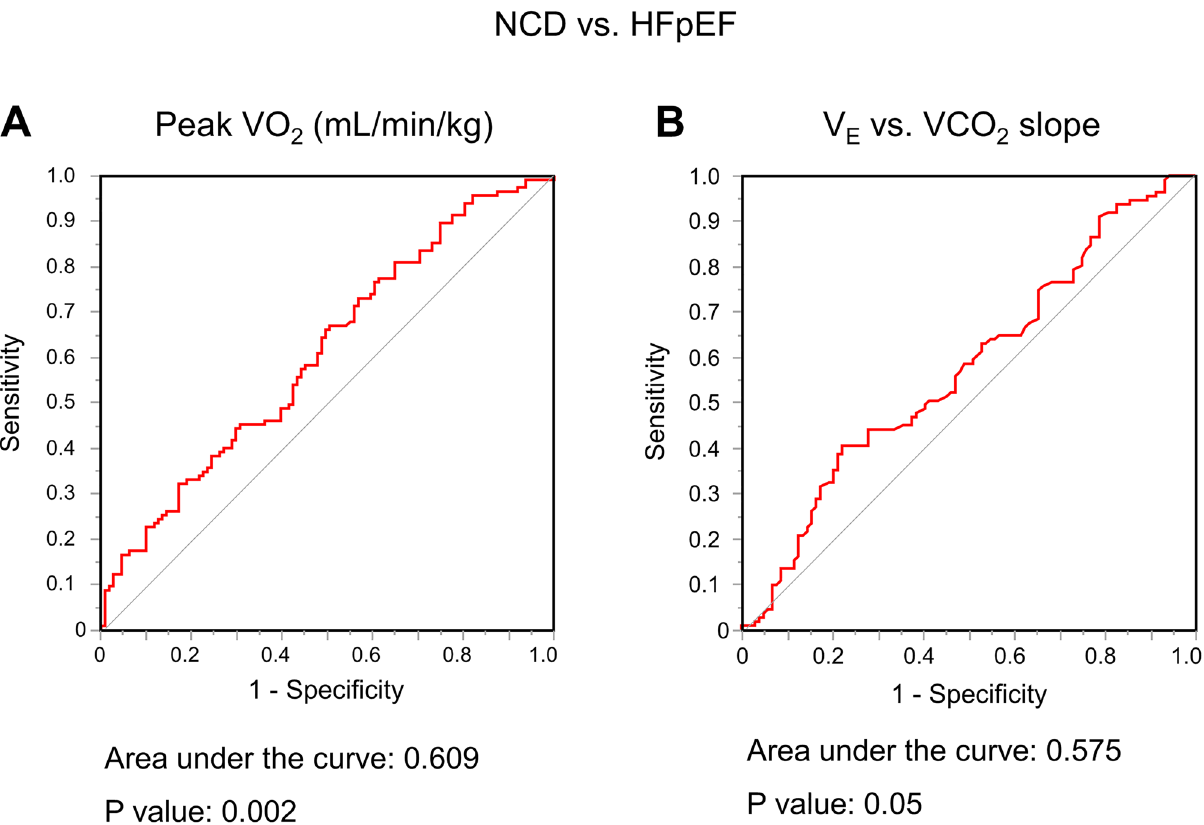
Figure 3. Receiver-operating characteristic curves of peak oxygen consumption (VO 2 ) ( A ) and minute ventilation (V E ) vs. carbon dioxide production (VCO 2 ) slope ( B ) for distinguishing HFpEF from NCD. Abbreviations as in Fig.